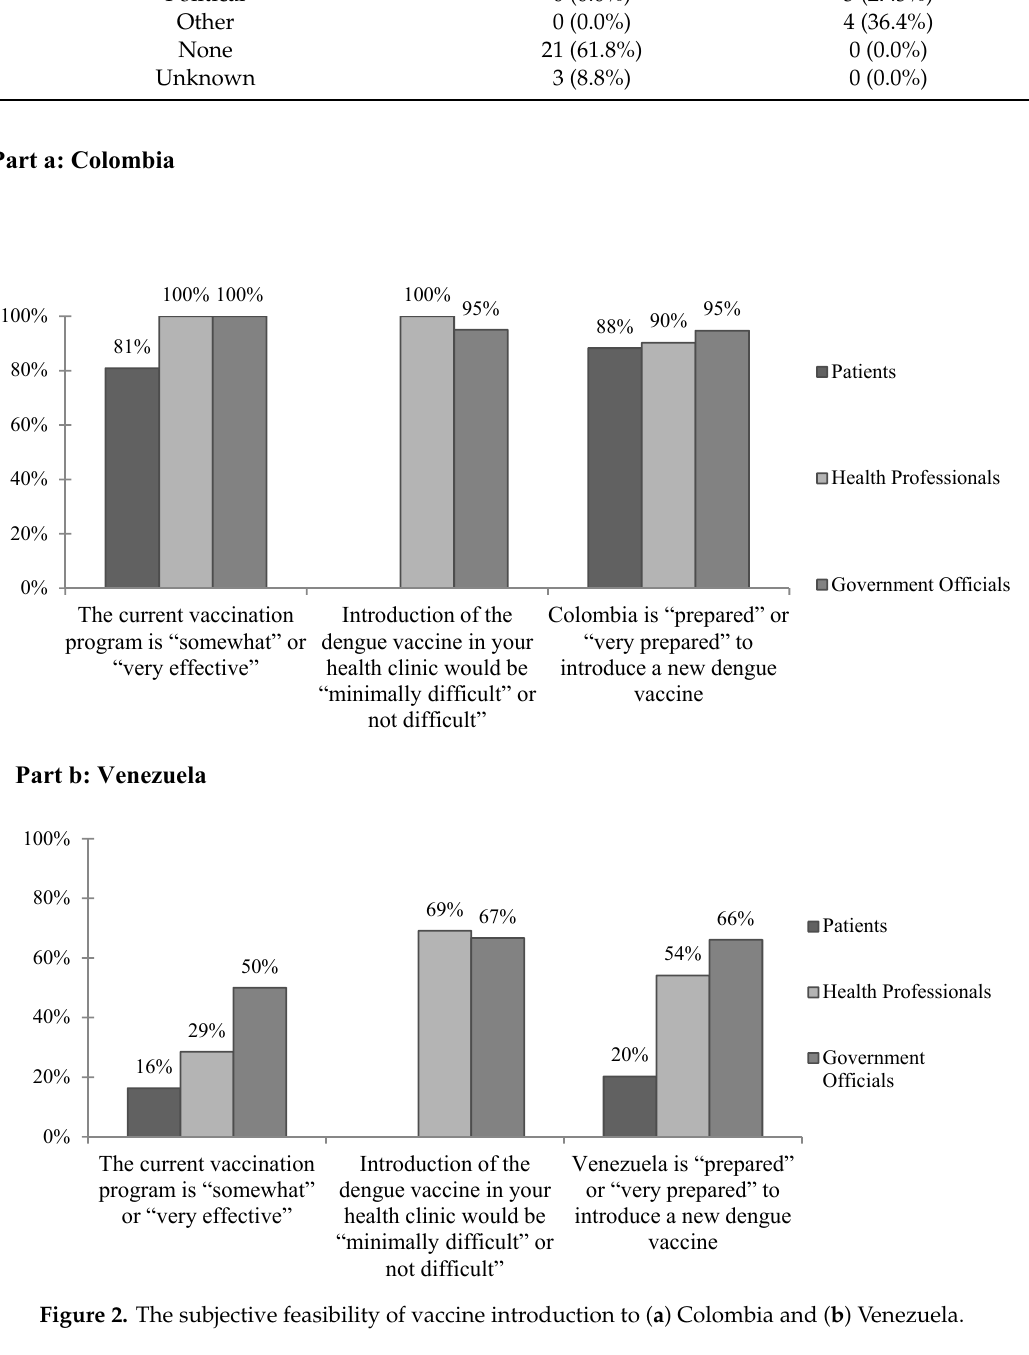
Table 3. Self-reported barriers to currently providing mandated vaccines and to implementing the dengue vaccine in Colombia. Free responses were then coded into the categories below.